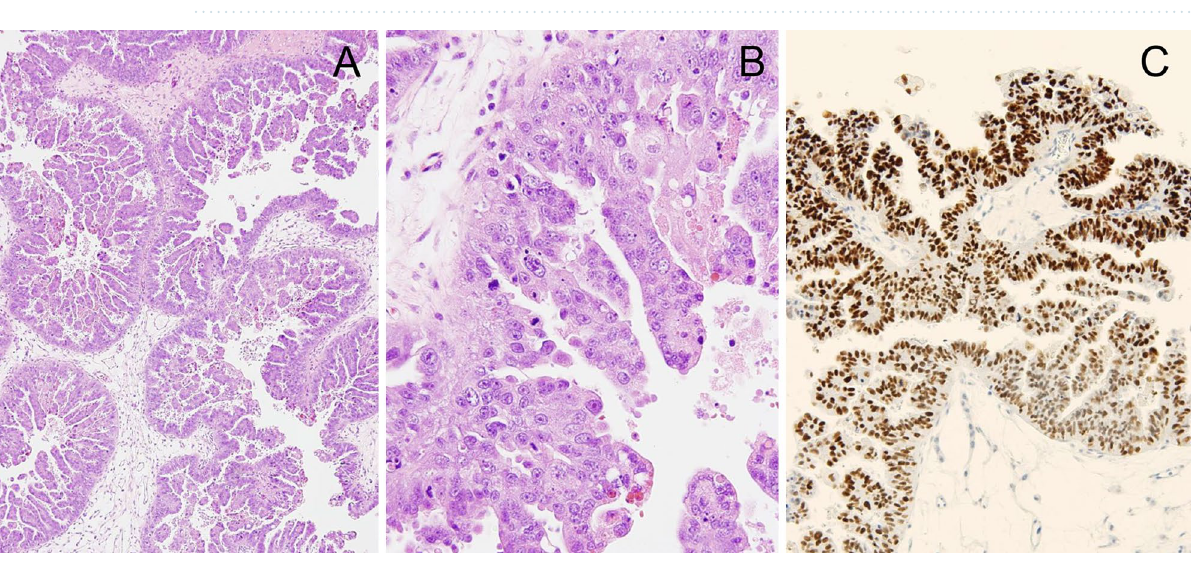
Figure 1. High grade serous ovarian carcinomas with intra-tumoral budding in a 48-year-old patient ( A ). Intra-tumoral budding was defined as a single tumor cell or a cell cluster of up to four tumor cells at the invasive tumor front. Single tumor cells and clusters of small numbers of tumor cells were noted at the invasive edge ( B ). p53 stained section showed aberrant overexpression ( C ).